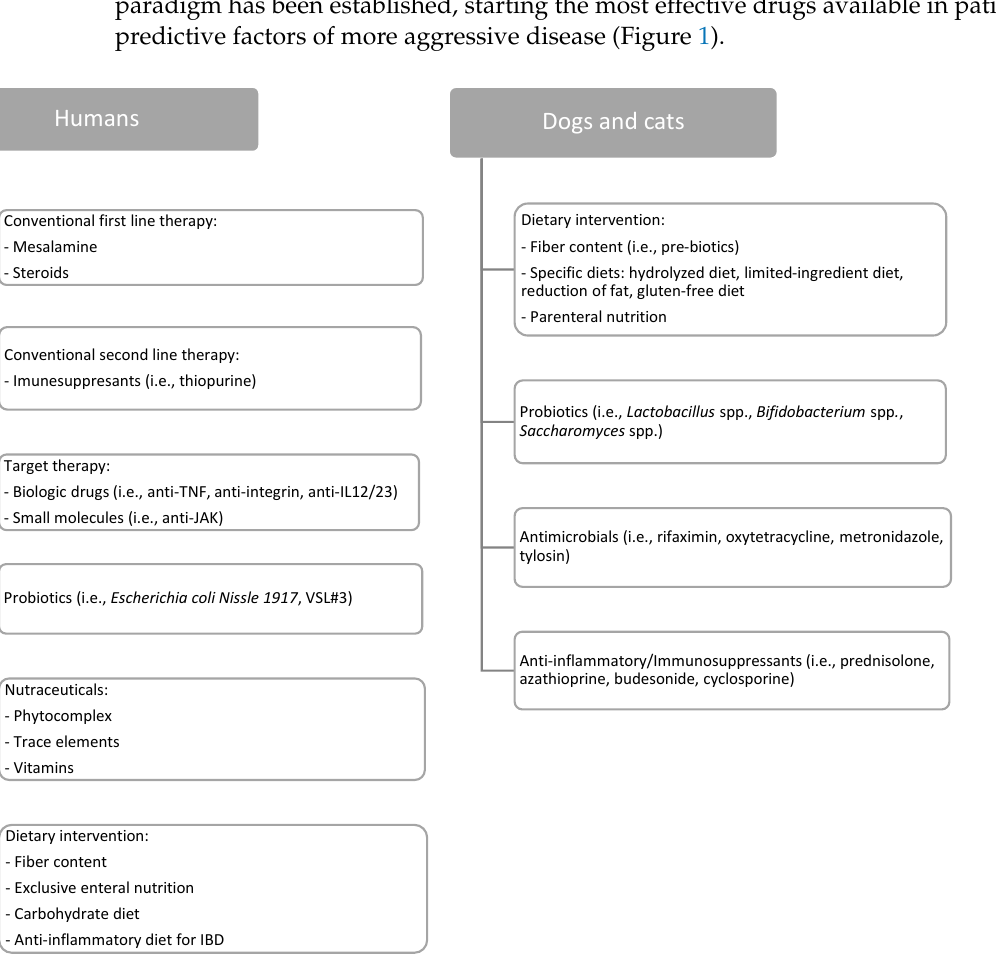
Figure 1. Stepwise approach to chronic intestinal disorders in humans and pets. UC = ulcerative colitis. In veterinary medicine, new approaches to the management of CID in dogs and cats have been developed over the last 30 years. However, therapy for CE is difficult to estab- lish, since the pathogenesis of the disease is not easily understood. The choice depends on the seriousness of the disease and the response to drugs. The most used therapies are an- timicrobials, immunosuppressants, and anti-inflammatory drugs. Unfortunately, the sci- entific evidence of the efficacy and effectiveness of these drugs in animals is lacking and variable across studies. There is stronger evidence for the use of controlled, elimination, and hydrolyzed diets, which are the first-choice approach for pets [5] (Section 4, Figure 1). When deciding which treatment is the most appropriate, adding symptomatic measures (gastroprotectors, antiemetics, motility modulators, etc.) would be beneficial to correct any imbalance. 3.1. Humans 3.1.1. Conventional Therapy Mesalamine represents the cornerstone of therapy of UC. Mesalamine is able to in- duce and maintain remission. It is most prescribed for UC with mild or moderate disease symptoms. Topical (rectal) plus oral mesalamine is the most efficacious mode of admin- istration. Mesalamine ’ s exact function is unclear, however the most accepted theory is that